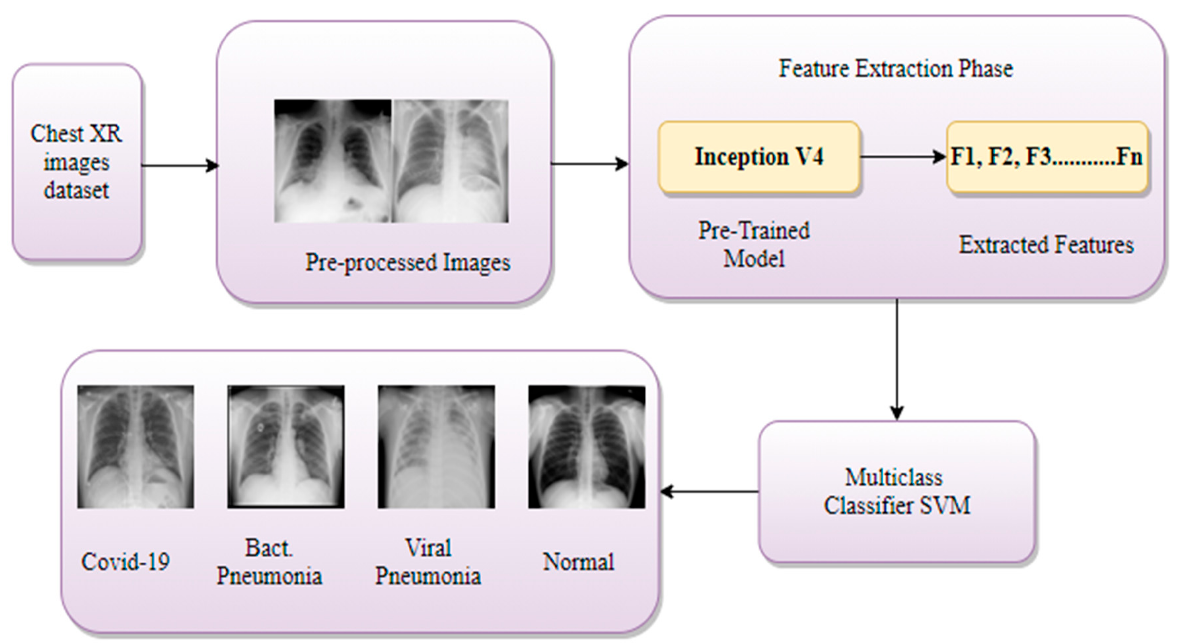
Figure 3. The architecture of the proposed C19D-Net.